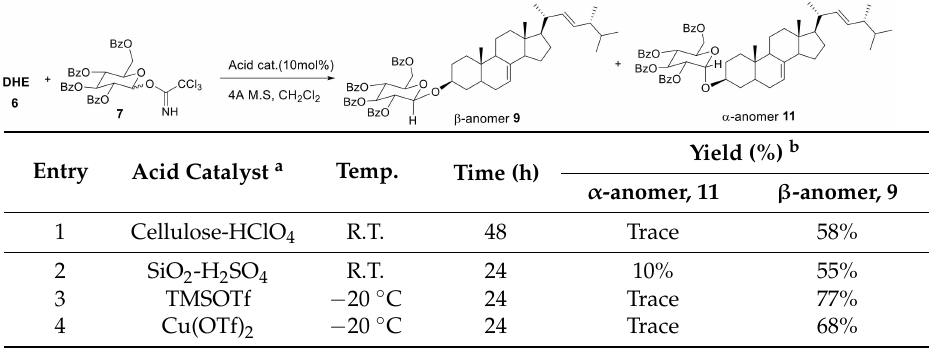
Yield (%) b Entry Acid Catalyst a Temp. Time (h) α -anomer, 11 β -anomer, 9 1 Cellulose-HClO 4 R.T. 48 Trace 58% 2 SiO 2 -H 2 SO 4 R.T. 24 10% 55% 3 TMSOTf − 20 ◦ C 24 Trace 77% 4 Cu(OTf) 2 − 20 ◦ C 24 Trace 68%